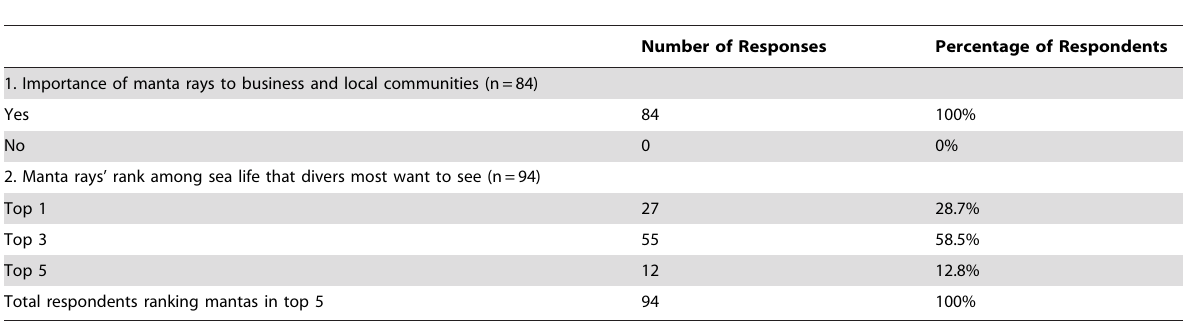
Table 4. Responses to Survey Questions on Dive Operator Perception